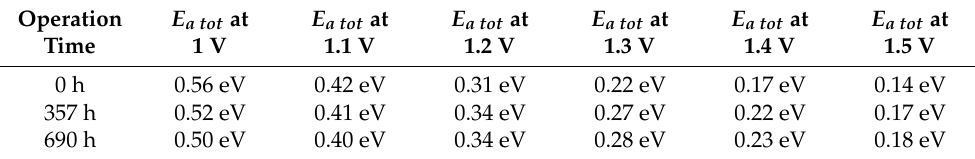
Table 2. Activation energies of the electrolysis cell at different voltages and time.